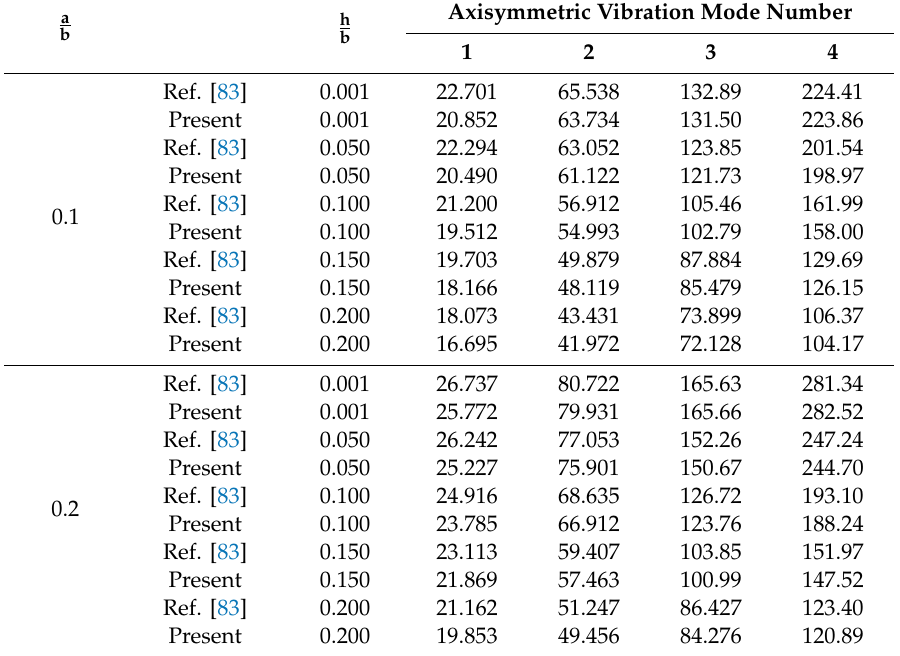
Table 3. Comparison of nondimensional natural frequency of the annular plate for di ff erent axisymmetric vibration mode number, inner radius to outer radius ratio, and thickness to outer radius ratio for clamp-simply boundary condition.